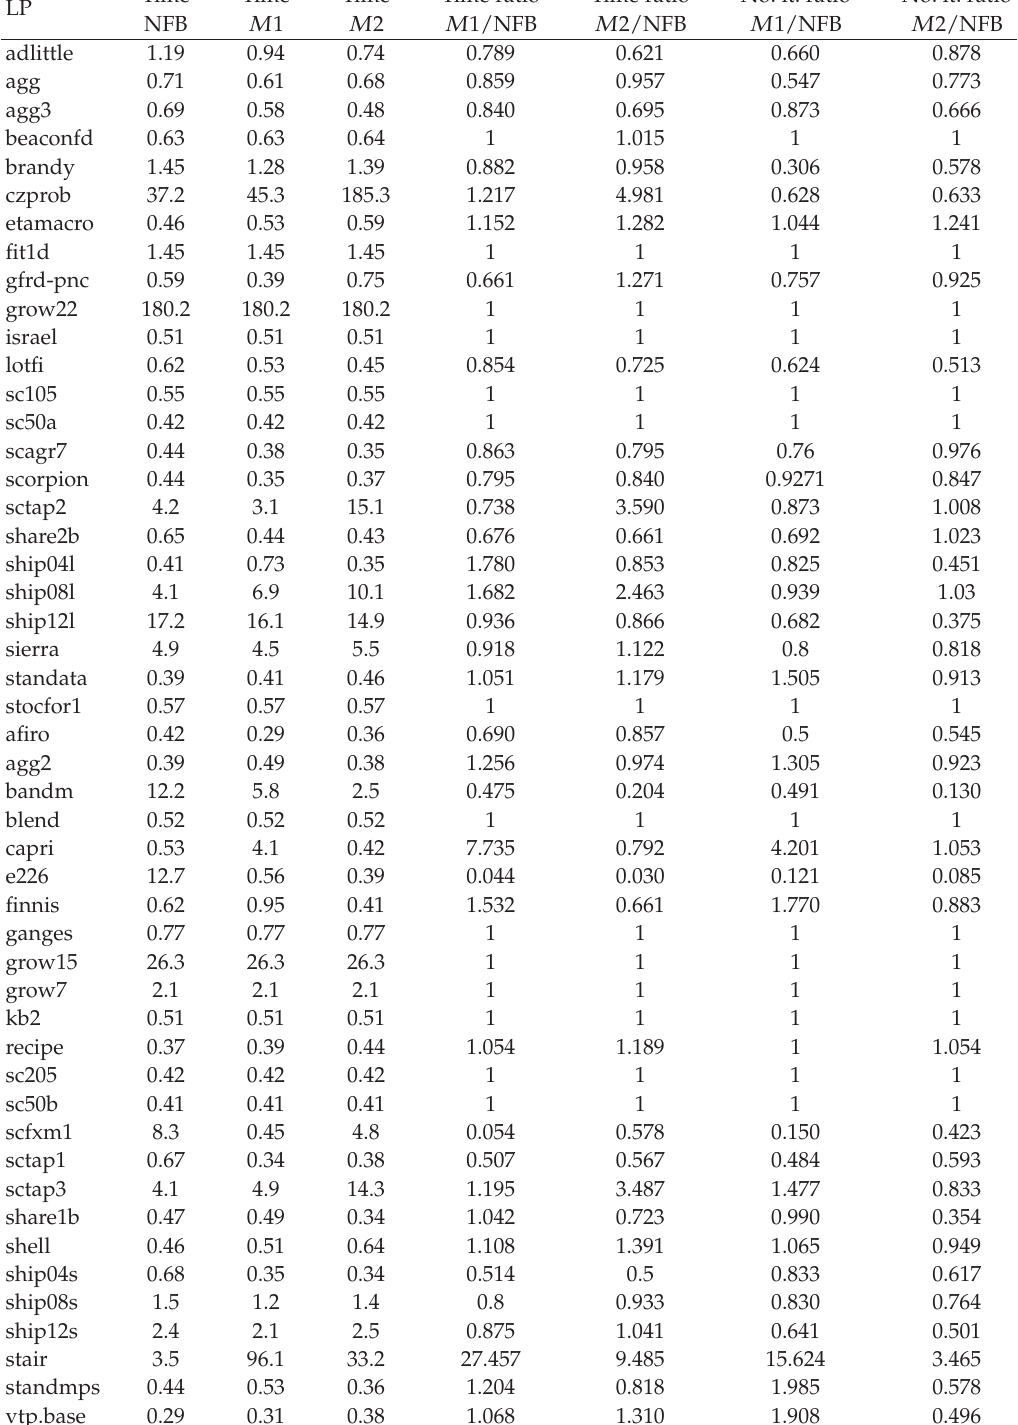
Table 4: The CPU time, the CPU time ratio, and the number of iteration